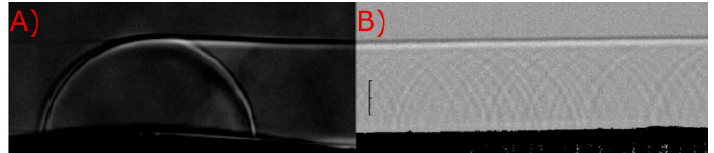
Figure 2. Characteristic schlieren images of the pressure wave induced by NS-DBD from two observation directions [20].